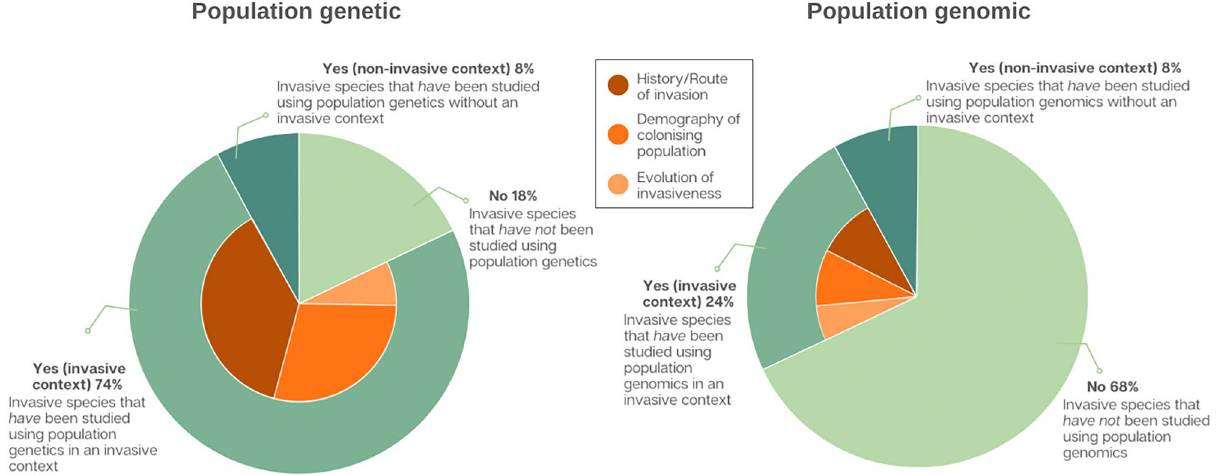
Figure 2. Proportion of invasive species from the WAS List (n = 100) for which researchers have utilised population genetic and population genomic data as a research